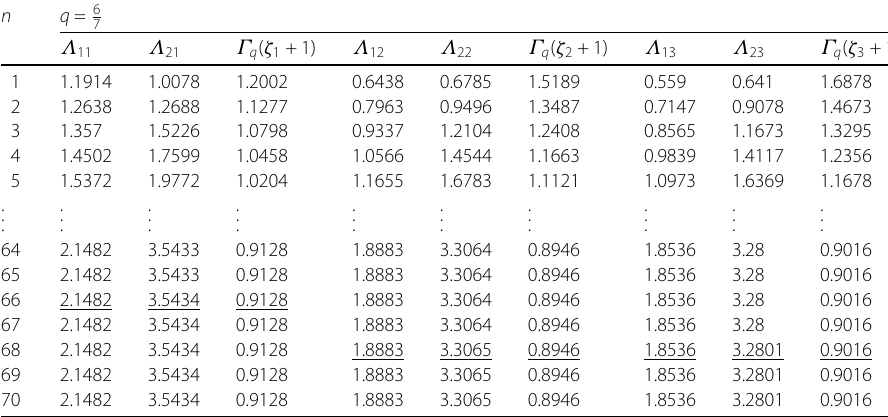
Table 4 Some numerical results of Λ 1 i , Λ 2 i , and Γ q ( ζ i + 1) in Example 1 for q = 6